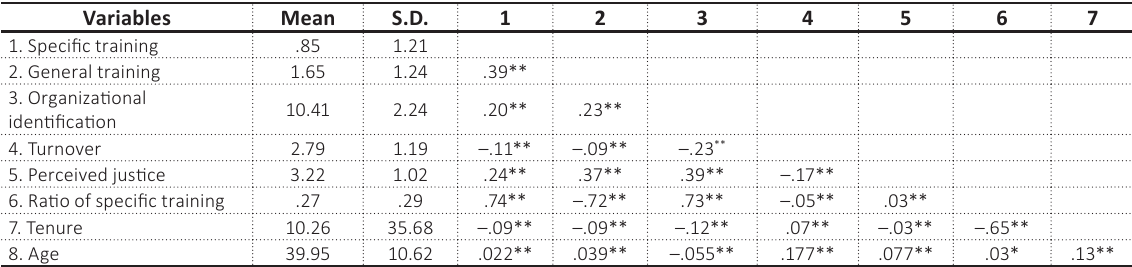
Table 1. Descriptive statistics and